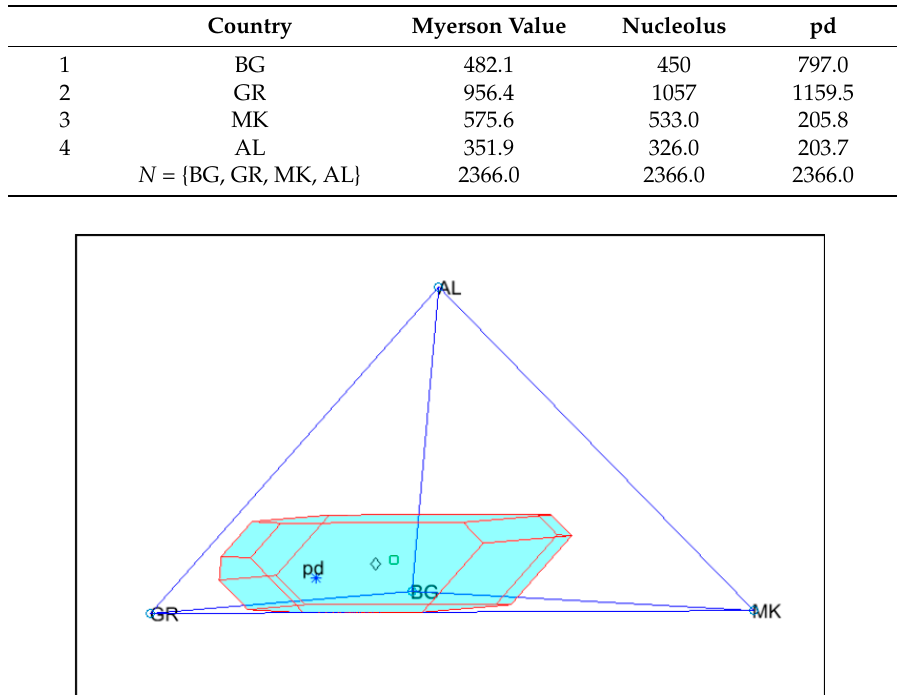
Figure 4. The core, Myerson value, nucleolus and proportional division of the 4-country game.